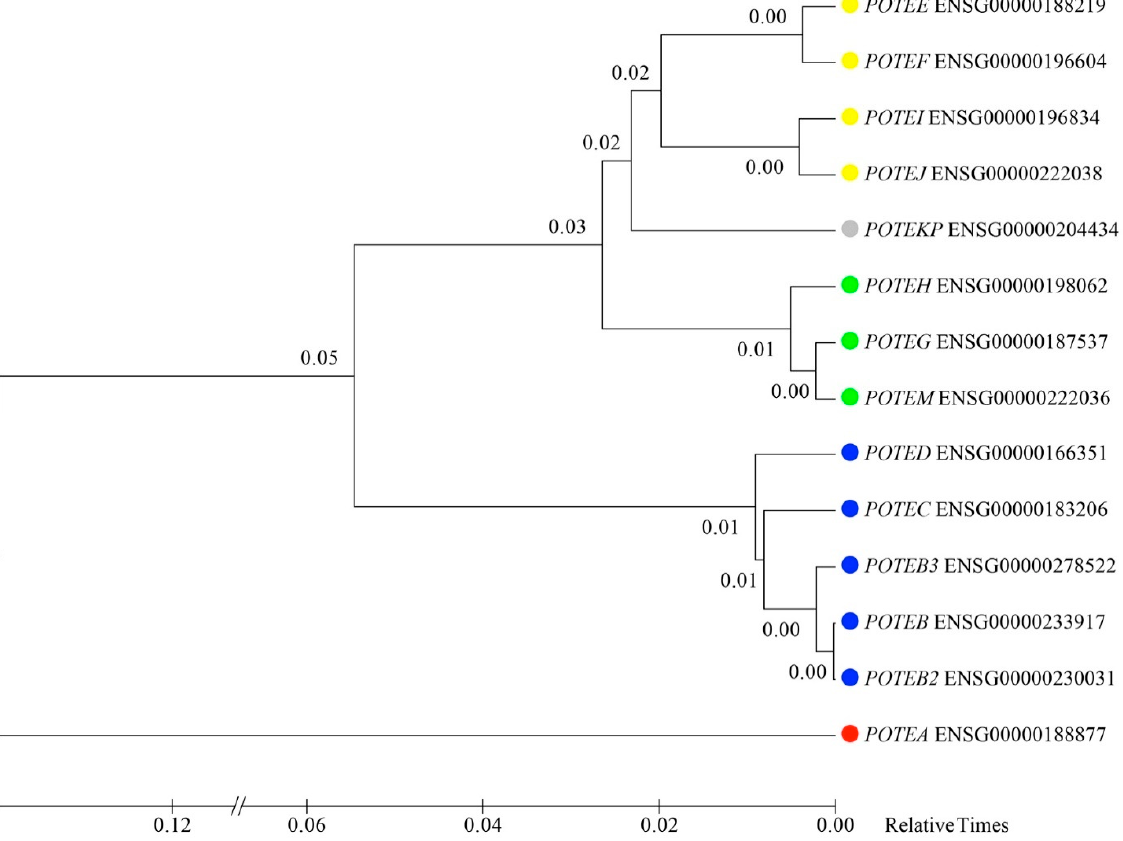
Figure 2. Phylogenetic tree built using the Ensembl genomic sequence of the 14 human POTE genes from exons 1 to 3. For each paralog, the Ensembl ID is indicated together with the approved symbol. Colored circles indicate the four different groups: red for group I, blue for group II, yellow for group III, and green for group IV. The estimated log likelihood value of the topology shown is − 19,591.8948. The tree is drawn to scale, with branch lengths measured in the relative number of substitutions per site.